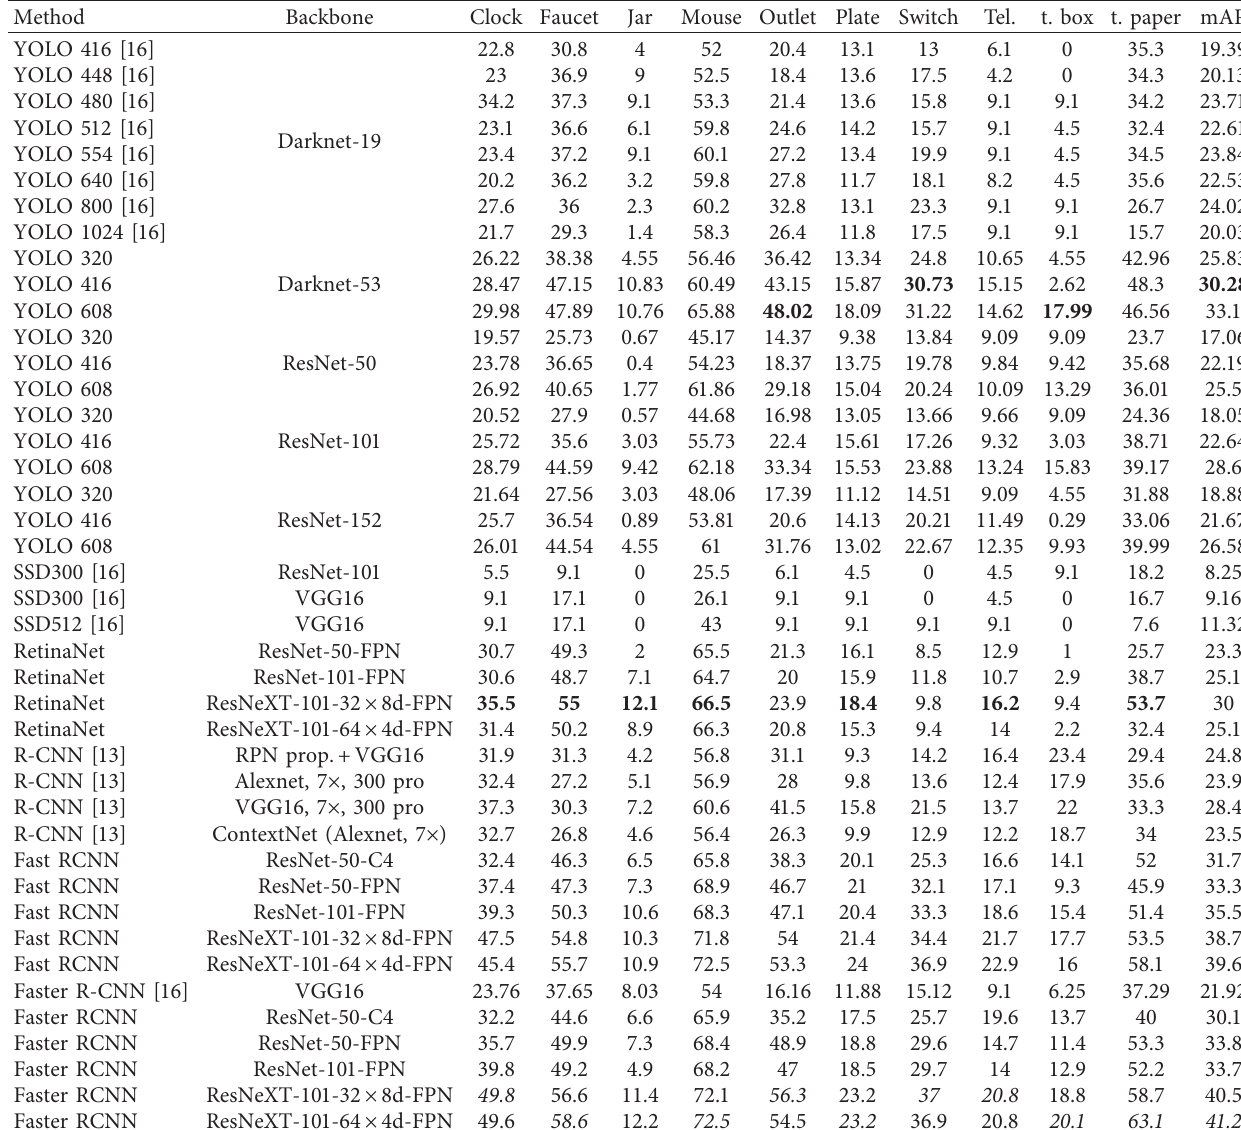
Table 3: Comparative results on small object dataset. Method Backbone Clock Faucet Jar Mouse Outlet Plate Switch Tel. t. box t. paper